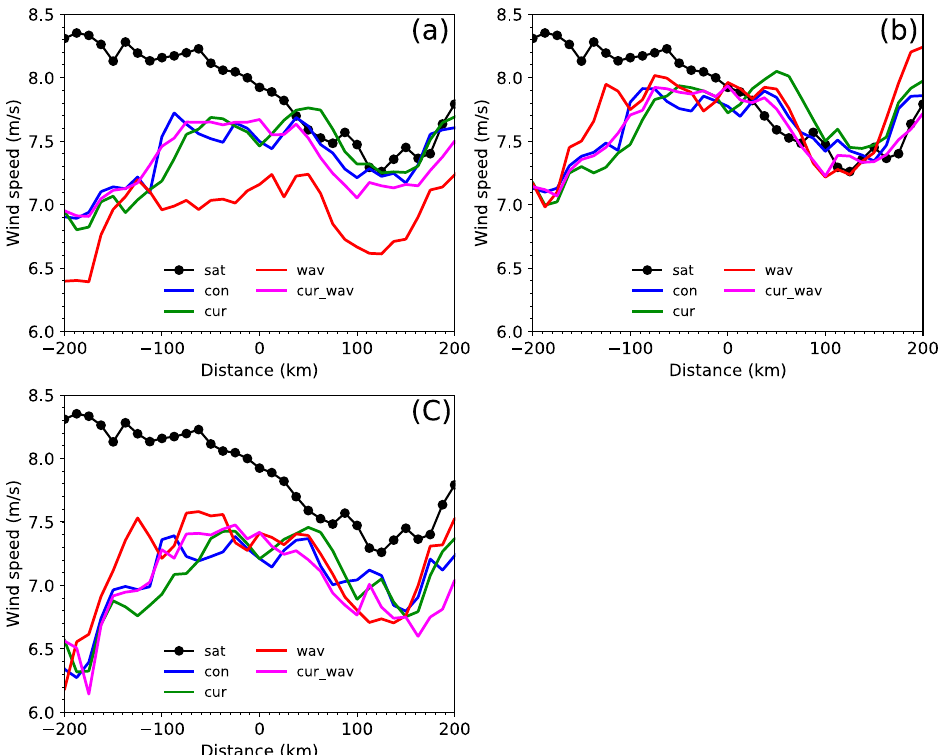
Figure 18. Comparison of the averaged ASCAT equivalent neutral winds (black dotted) to ( a ) model winds, ( b ) model winds converted to neutral winds using the COARE 3.0 roughness length algorithm, and ( c ) model winds converted to neutral winds using the Bourassa [11] algorithm.